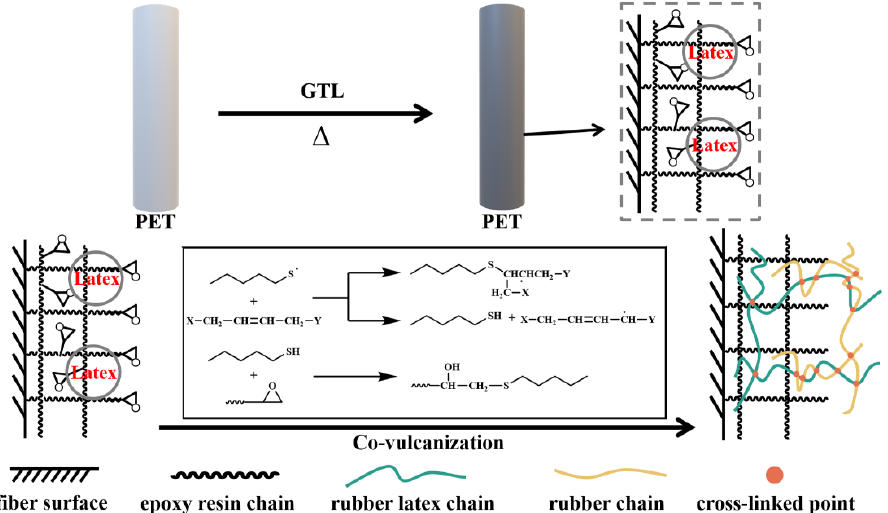
Figure 4. Possible schematic diagram of the chemical interactions between PET-GTL and rubber.